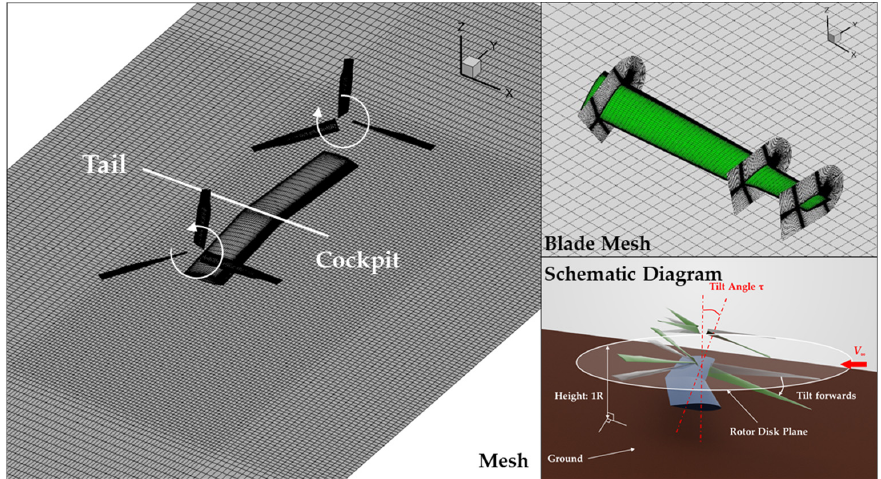
Figure 2. Grid system to simulate the flow field of a tiltrotor during shipboard take-off and landing.